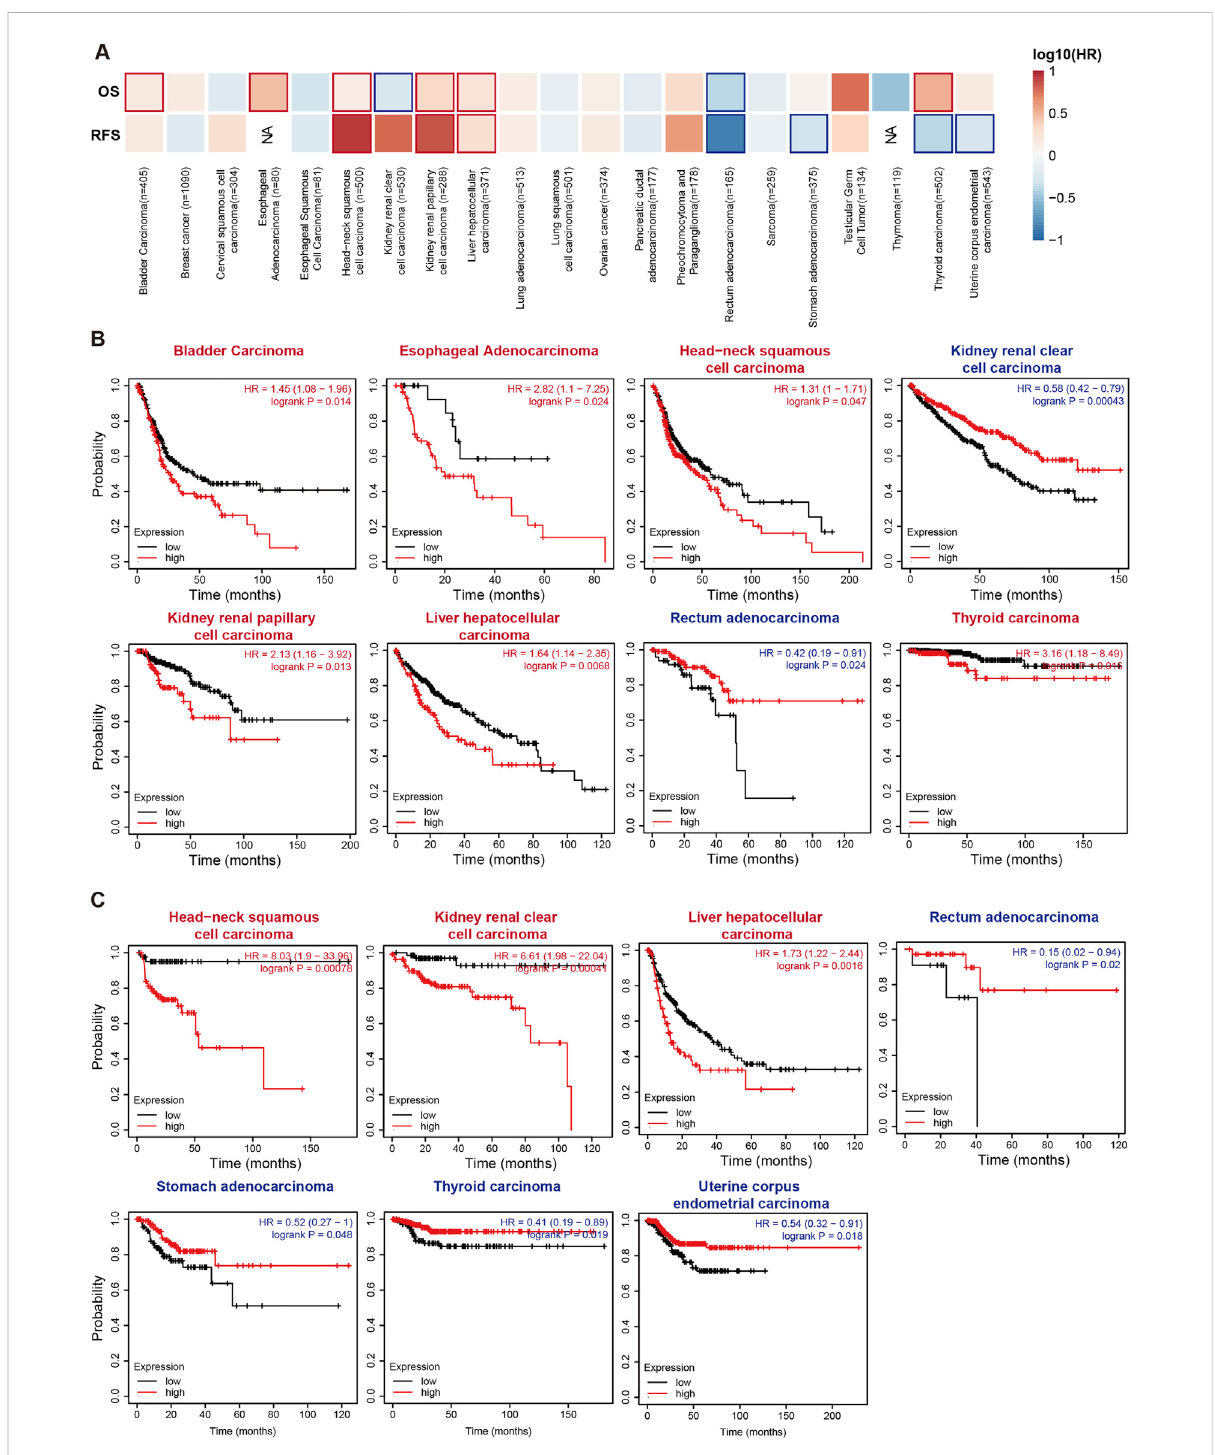
Relevance between RIOK2 gene expression and survival prognosis of cancers in TCGA. (A) The correlation between RIOK2 expression and overall survivaland relapse-free survivalacross multiple cancertypesisshownin aheatmap.The bold borderin theheatmap representssigni fi cance ( p < 0.05). (B,C) The overall and relapse-free survival Kaplan-Meier curves of the various cancer types that have signi fi cant survival risk ( p < 0.05) are displayed, with high RIOK2 expression curves colored in red and low ones in